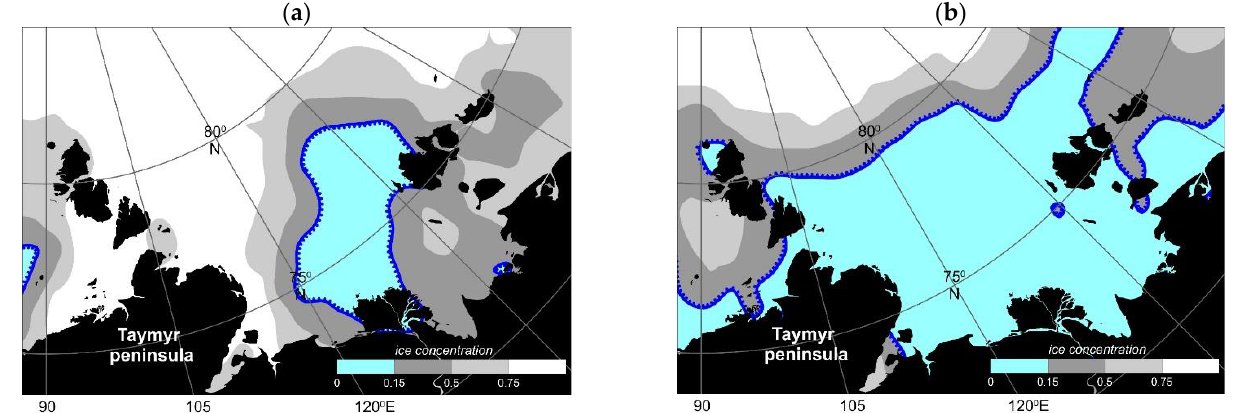
Figure 3. Sea ice extent (white) and open water (blue) in the Laptev Sea on July 15 in 2005 ( a ) and in 2020 ( b ), based on data from [5].